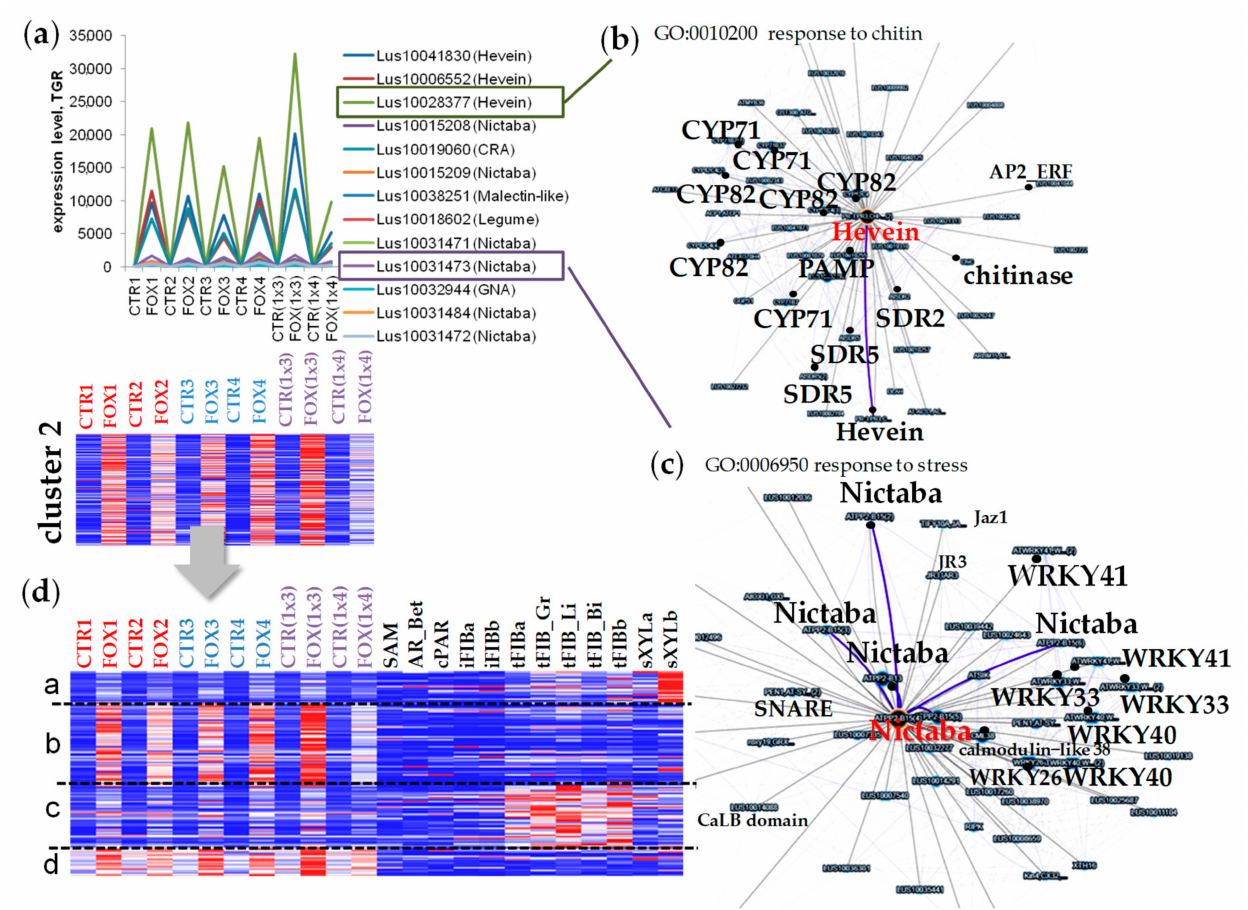
Figure 5. ( a ) The expression of several lectin genes mostly activated in the root tips during Fusarium oxysporum infection in all analyzed cultivars. ( b ) The coexpression network for Lus10028377 (Hevein family), its coexpressed genes, and their gene ontology (GO, for orthologous genes in Arabidopsis). ( c ) The coexpression network for Lus10031473 (Nictaba family), its coexpressed genes, and their gene ontology (GO, for orthologous genes in Arabidopsis). ( d ) The cluster analysis of 146 genes upregulated in the root tips after inoculation with F. oxysporum for root and stem samples. Options for clustering: the k-means (4 clusters) method, a distance measured by the Pearson correlation, local (auto) scale. The color gradient of the red-blue heatmap reflects TGR values from minimum (blue) to maximum (red) in the row. CTR1,2,3,4,(1x3),(1x4)—untreated root tips of various flax genotypes; FOX1,2,3,4,(1x3),(1x4)—the treated root tips of various flax genotypes [10]. SAM—shoot apical meristem [15]; AR_Bet—apical region (unpublished), cPAR—parenchyma cells, iFIB—the intrusively growing phloem fibers [16,17]; tFIBa, tFIB_Gr, tFIB_Li, tFIB_Bi, tFIBb—the isolated phloem fibers with tertiary cell wall (different cultivars, [17–19]; sXYLa, sXYLb—xylem part of the stem enriched with secondary cell wall [17,18]. The detailed sample descriptions and references are presented in FIBexDB and in the supplementary files of the related paper